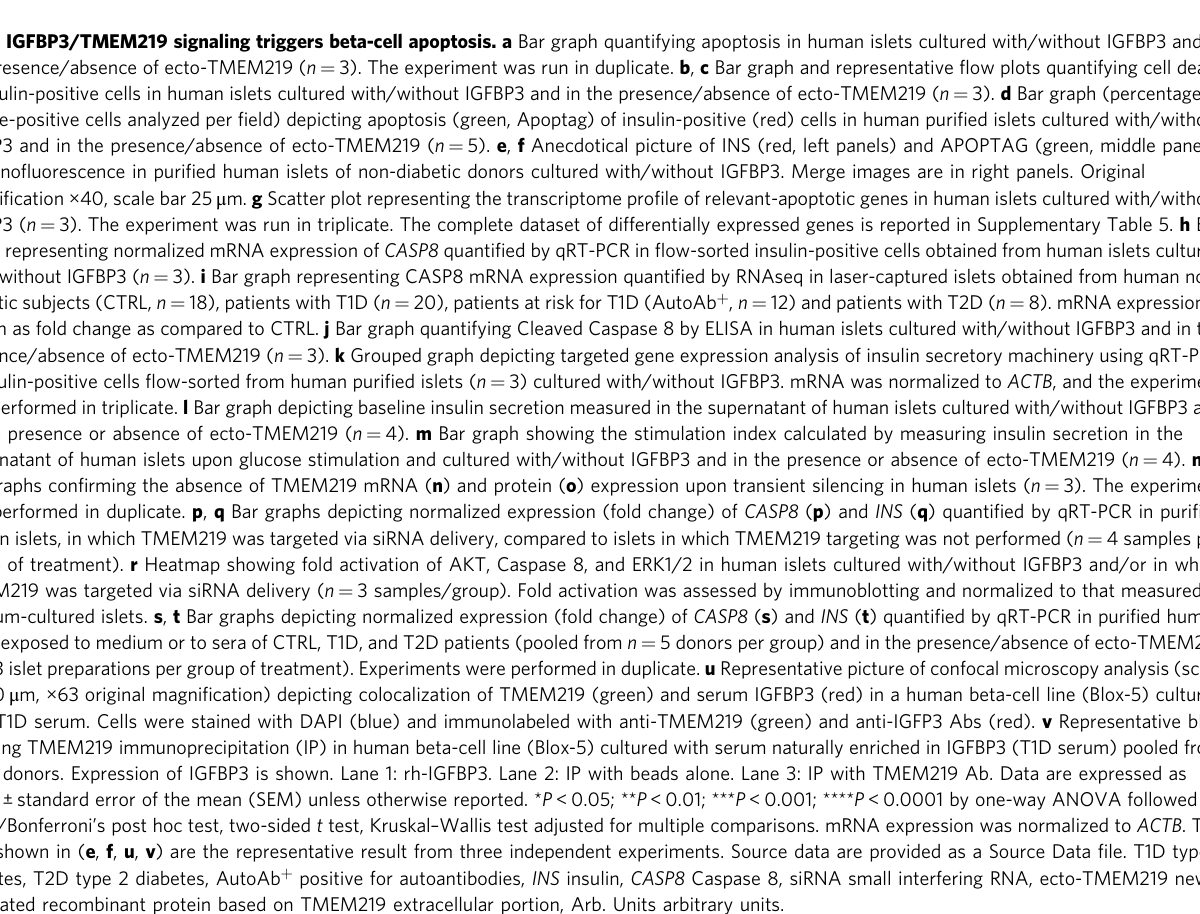
Fig. 3 IGFBP3/TMEM219 signaling triggers beta-cell apoptosis. a Bar graph quantifying apoptosis in human islets cultured with/without IGFBP3 and